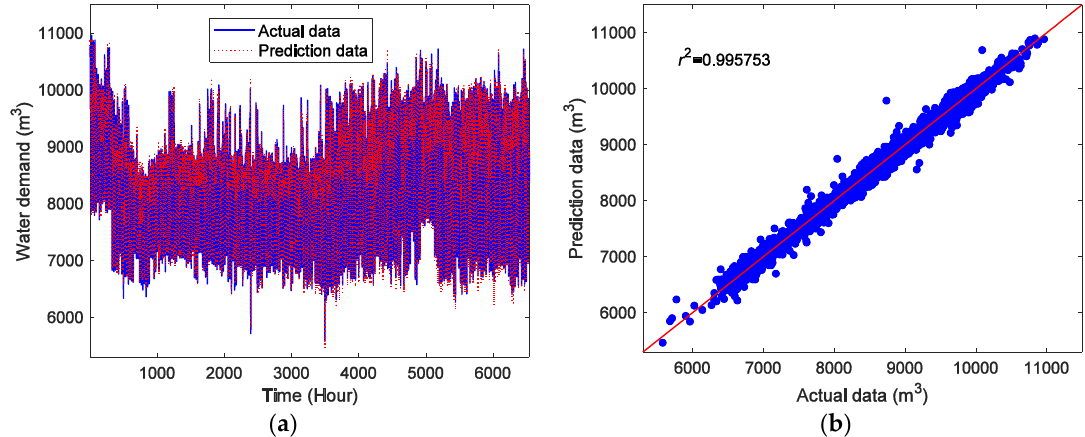
Figure 5. Forecasting results and scatter plots by the CDBESN model for the training data: ( a ) Shows the forecasting results, and ( b ) shows the scatter plots.